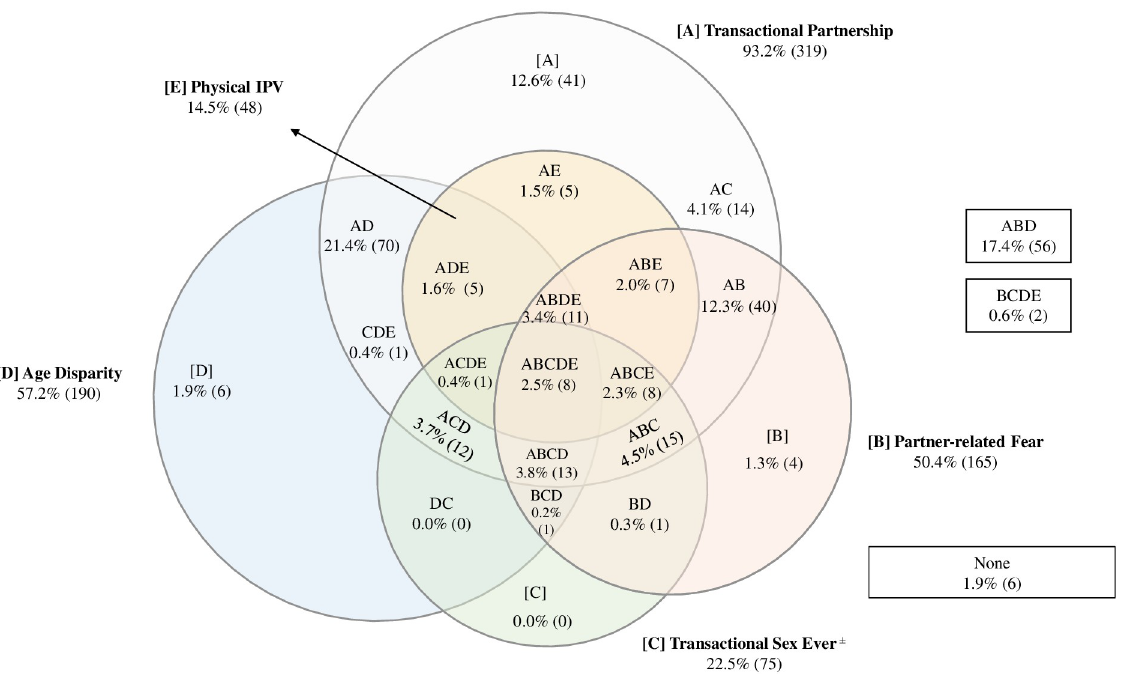
Fig 1. Venn diagram depicting gendered power imbalances at the interpersonal level in Nairobi, weighted (n = 332) / . [A] Transactional partnership. [B] Partner-related fear. [C] Transactional sex (ever). [D] Age disparity. [E] Intimate partner violence (IPV). / cells are mutually exclusive; not proportionate to size; numbers fluctuate due to small amounts of missing data. ± Indicates lifetime measure, not specific to current partnership.